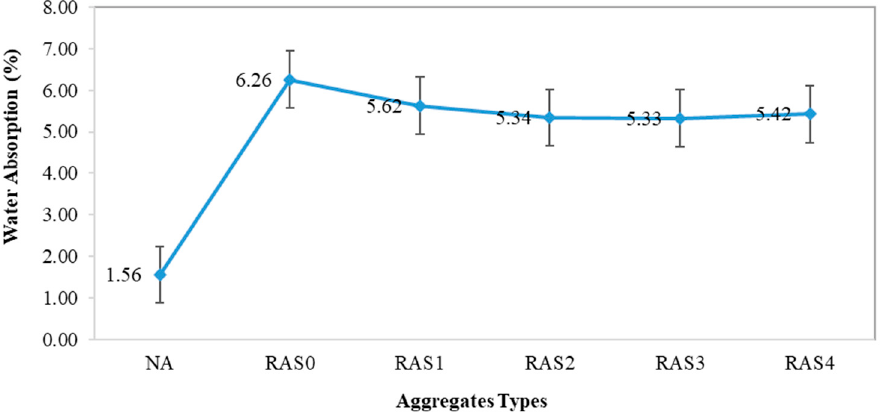
Figure 6. Water absorption results.